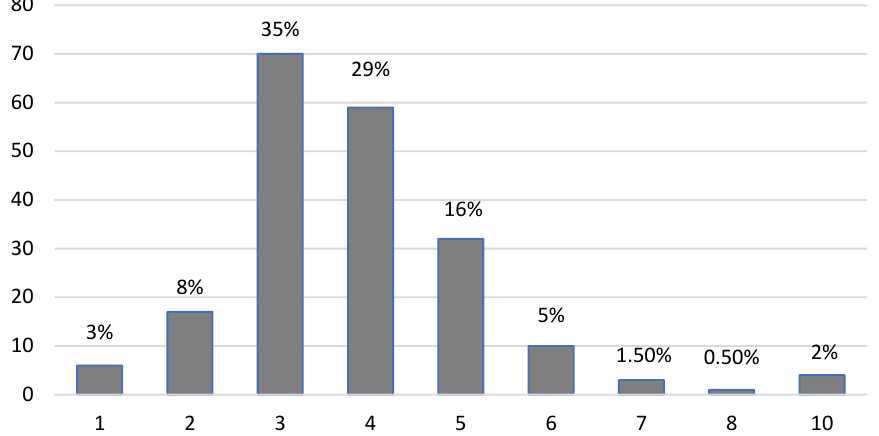
Figure 1. VFR relationships of Chinese immigrants before settling in Hungary.